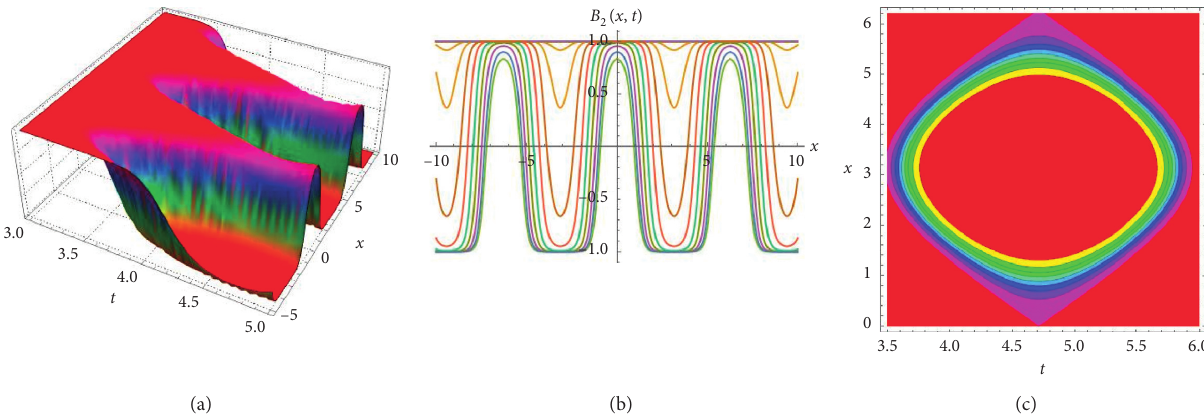
Figure 1: Periodic kink solitary wave solutions of equation (11) in three-dimensional, two-dimensional, and contour plot 3D � 3 , μ � − 9 , c � − 3 , and ϑ � 2. for λ � 6 , a 1